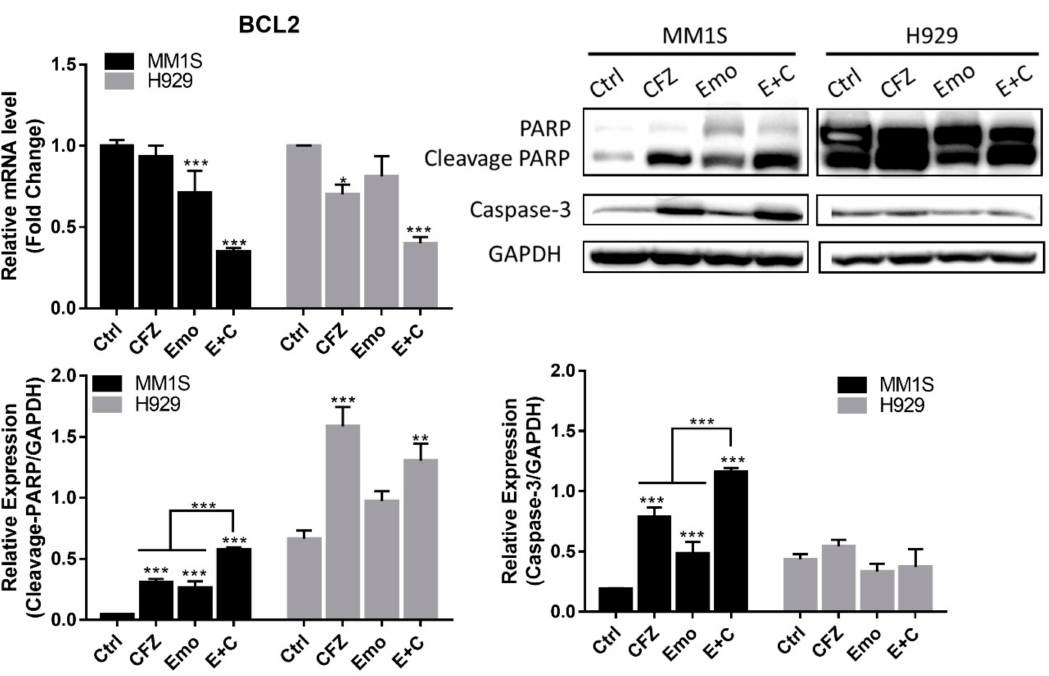
Figure 5. The combination therapy of carfilzomib (CFZ) and emodin (Emo) causes apoptosis in MM cells. The cells were incubated with CFZ (5 nM), Emo (30 µ M), or the combination (E + C) for 24 h. * p < 0.05; ** p < 0.01; *** p < 0.001.